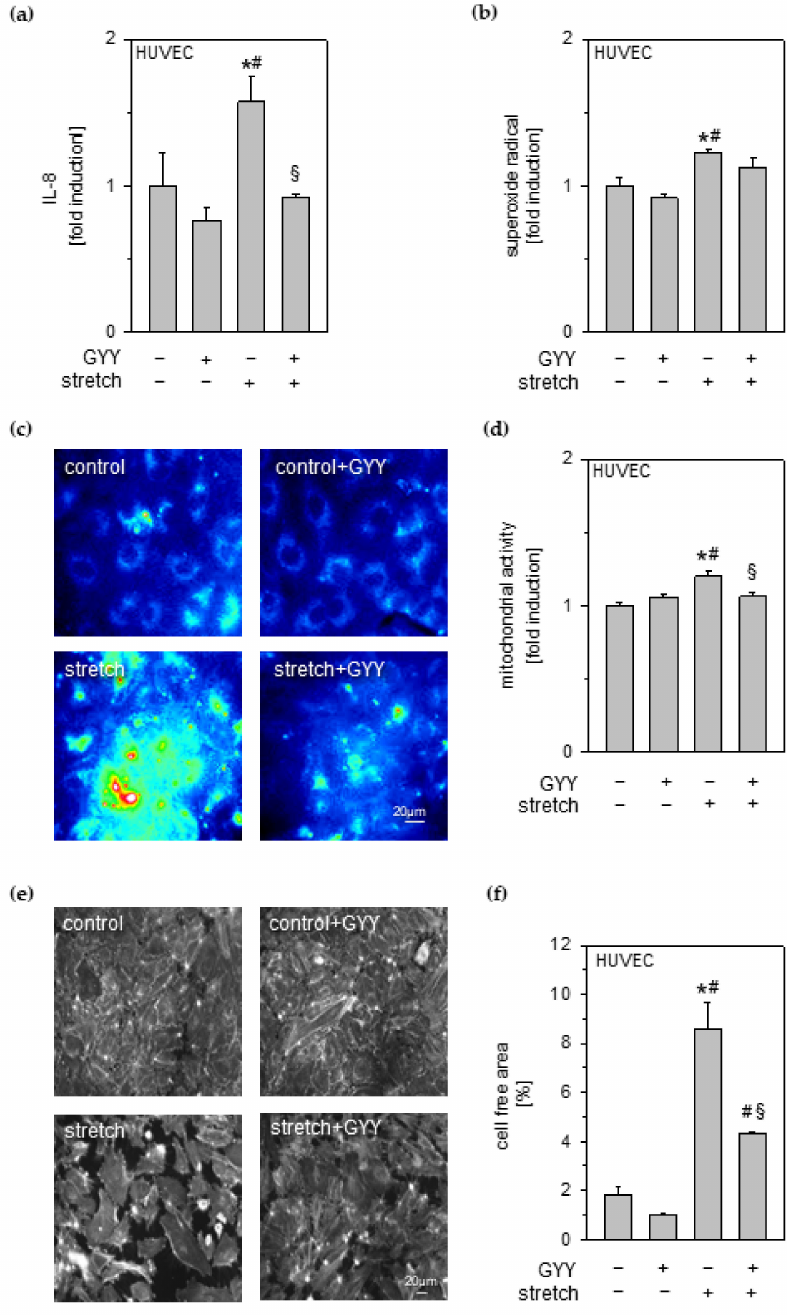
Figure 4. Effects of cyclic stretch and hydrogen sulfide on inflammation, ROS, and intercellu- lar integrity in endothelial cells. HUVEC endothelial cells stretched and incubated with 1 mM GYY4137, as indicated. ( a ) The amount of IL-8 in cell medium supernatant was determined by ELISA. ( b ) Densitometric analysis of DHE staining for superoxide radicals. ( c ) Representative rainbow false- colored images of mitochondrial staining and ( d ) densitometric analysis of mitochondrial activity. ( e ) Representative images of actin fluorescence staining and ( f ) evaluation of cell free areas. Data represent means ± SEM for n = 3/group. Analysis of variance (Tukey’s post hoc test), * p < 0.05 vs. control; # p < 0.05 vs. control + GYY; § p < 0.05 vs.